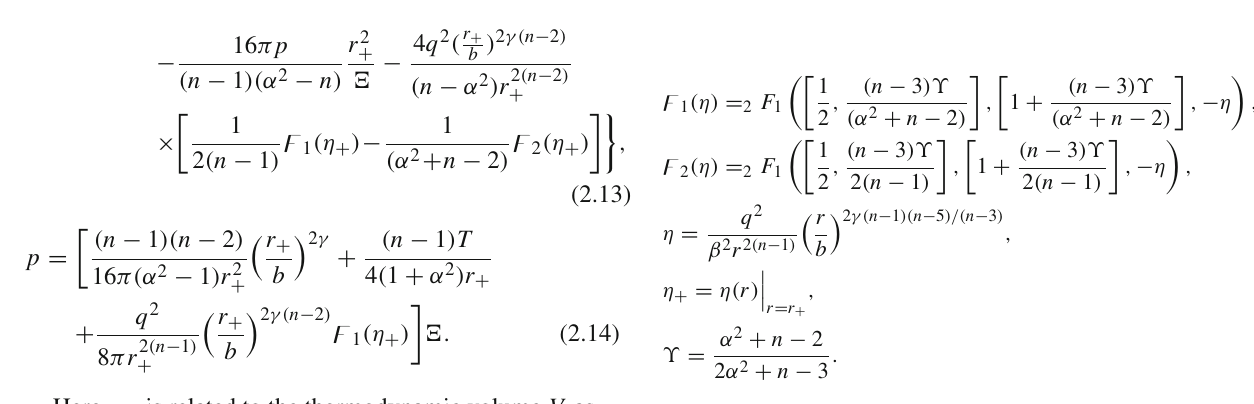
Fig. 9 The behavior of the pressures of upper isobar ( p 1 ) and lower isobar ( p 3 ) for engine cycle with respect to α in: a Einstein–BI–dilaton theory and b BD–BI theory. (see the caption of Fig. 2 for the parameter